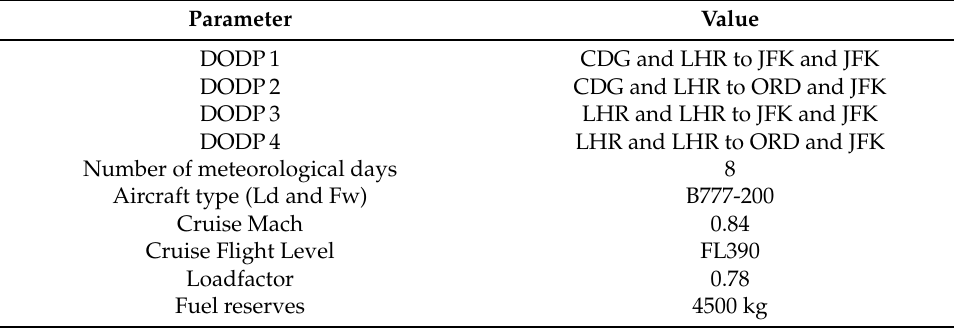
Table 1. Scope of